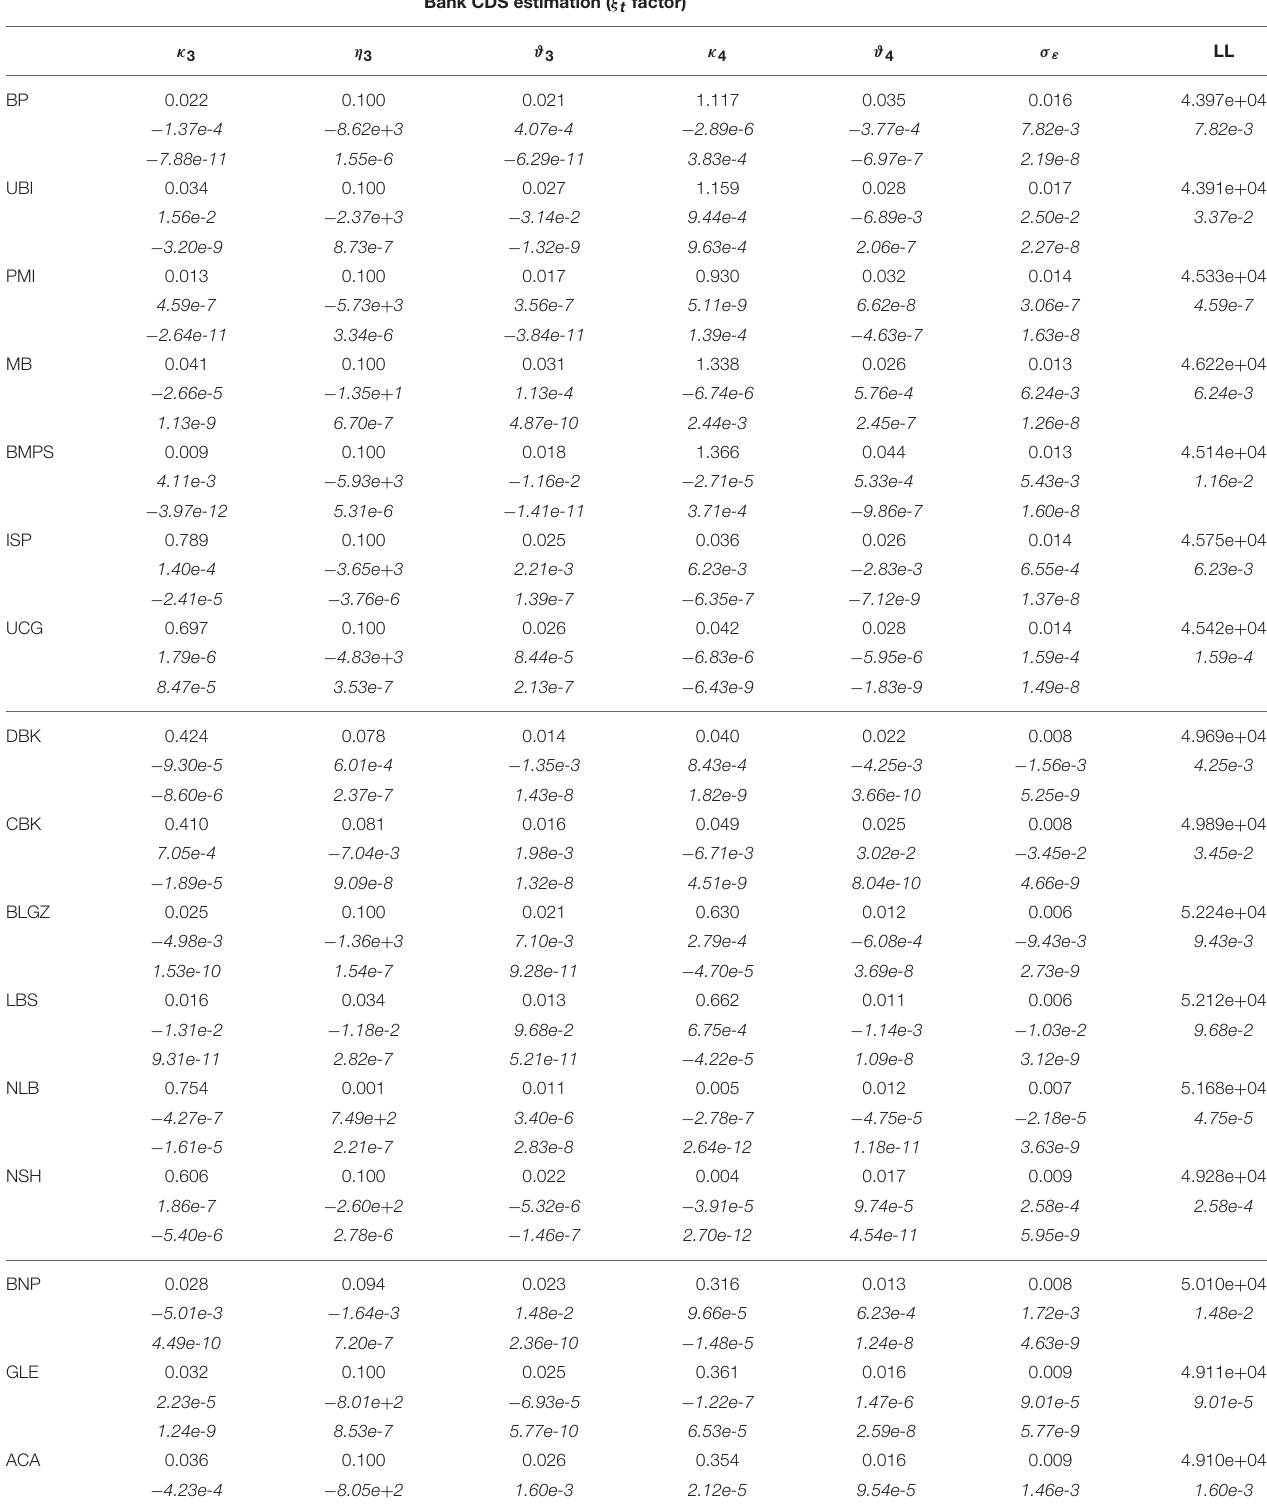
TABLE 7 | Estimated parameters of the multi-factor Vasicek